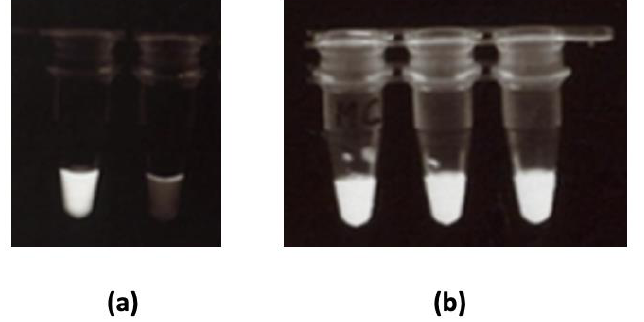
Figure 6. Loop-mediated isothermal amplification (LAMP) of C. gloeosporioides DNA extracted using ( a ) a conventional extraction kit: white tube had C. gloeosporioides DNA extract, clear tube had no DNA (negative control); ( b ) in-house simplified method C for C. gloeosporioides ( n = 3). Fluorescence (milky white) indicated successful amplification.